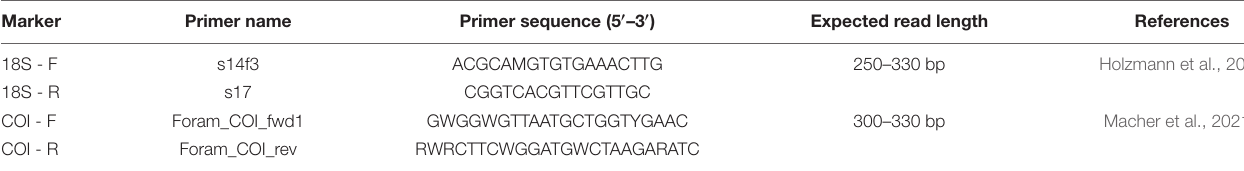
TABLE 1 | Primer sets used for amplification of the targeted DNA regions COI and